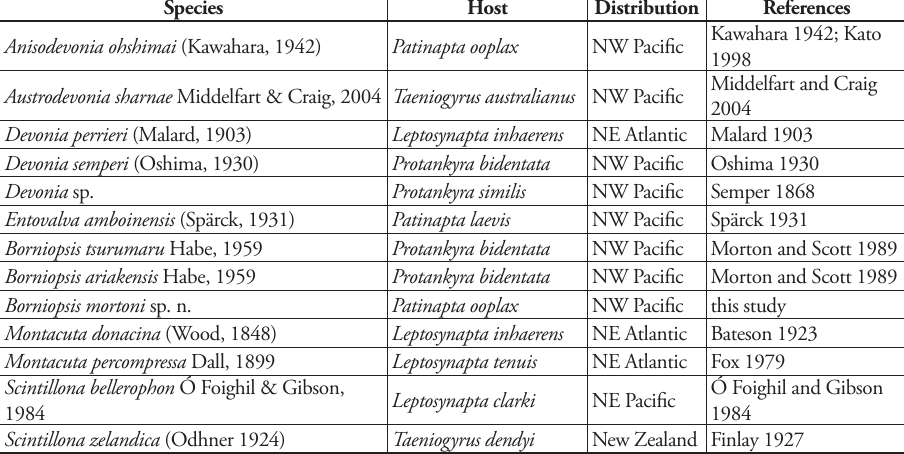
Table 1. Galeommatoidean bivalves commensal with apodid sea